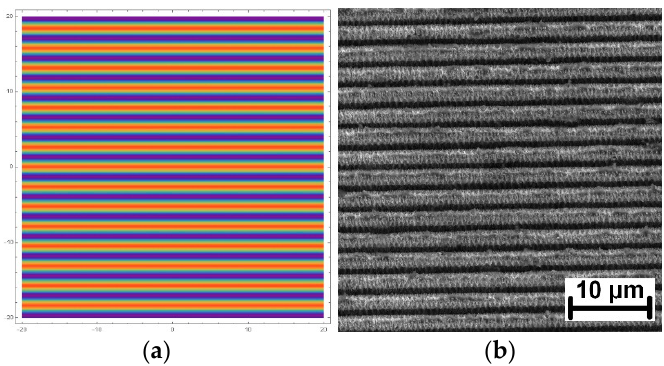
Figure 1. ( a ) Calculated pattern for two beam interference with a periodicity of 2.64 µm; ( b ) SEM image of the pattern fabricated on stainless steel with the same periodicity.